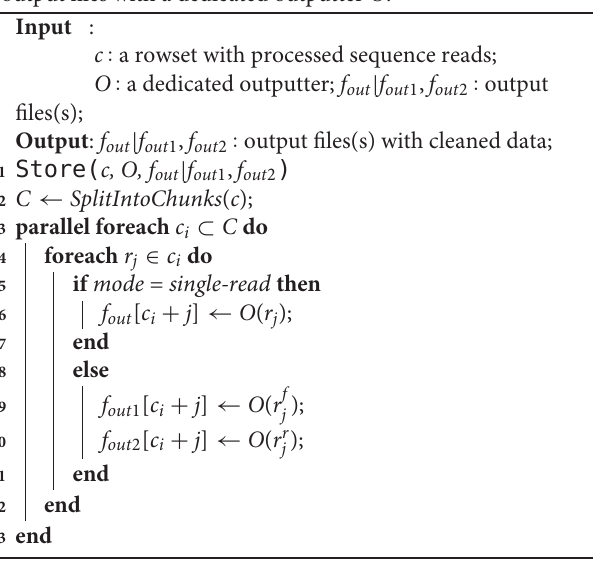
Algorithm 4: Storing a processed rowset of NGS data